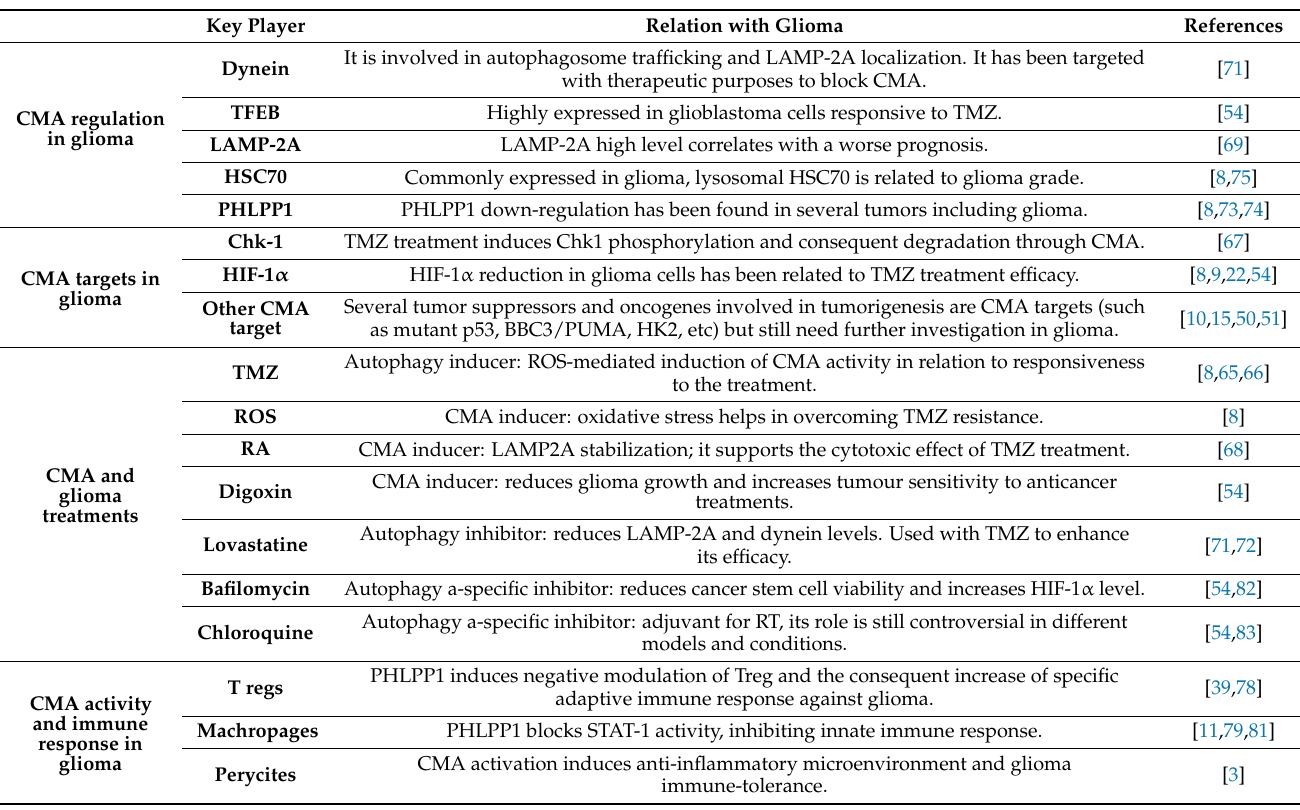
Table 1. Description of the CMA activities and regulations involved in glioma features and responsiveness to treatments. Key